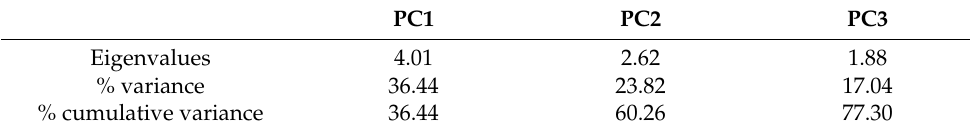
Table 4. Variance in principal components and cumulative contribution to total variance.